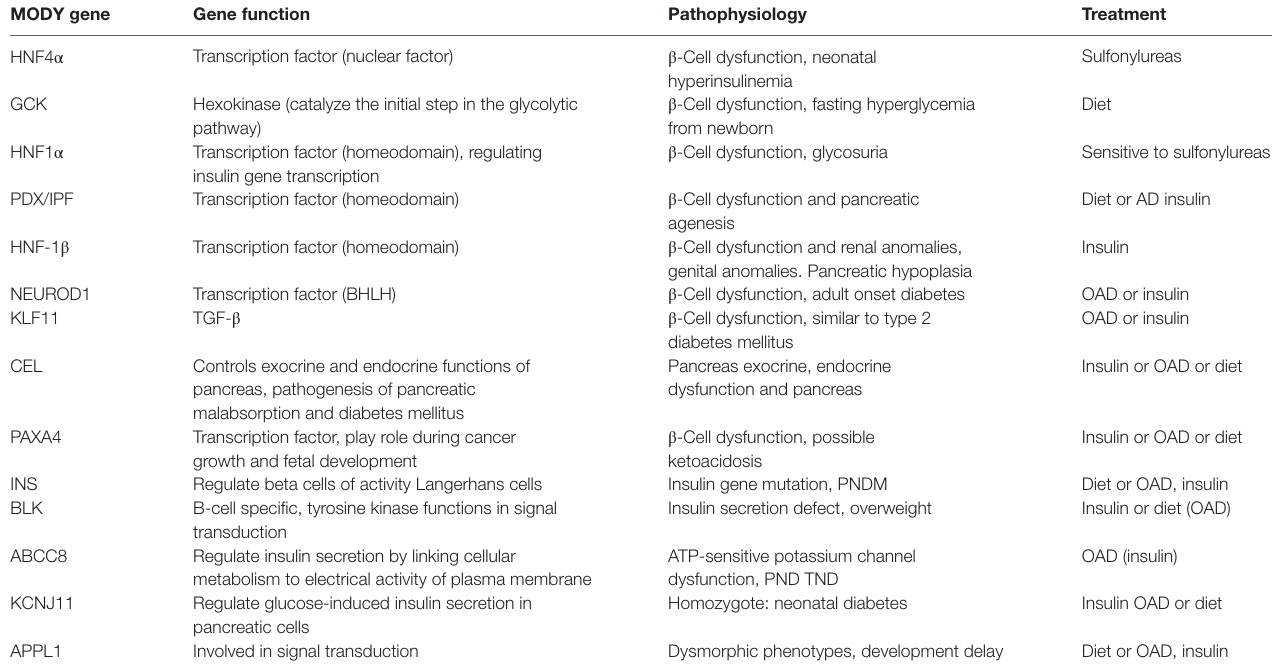
TAbLe 3 | Maturity-onset diabetes of the young (MODY) gene functions and pathophysiology and possible